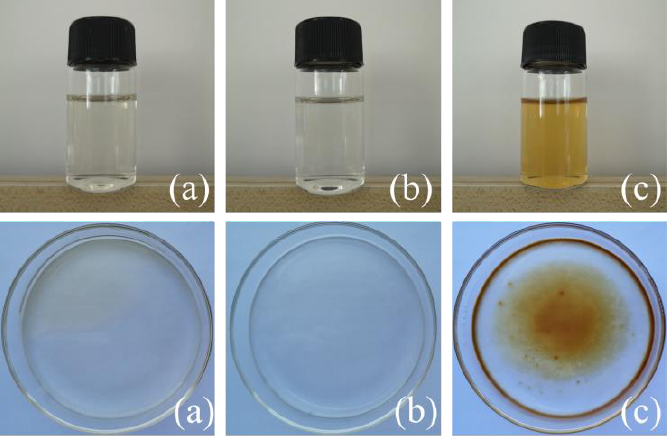
Figure 2. Photographs of the solutions ( top ) and films ( bottom ) prepared with 1% ( a ) chitosan, ( b ) carboxymethyl chitosan, and ( c ) chitooligosaccharide from left to right.